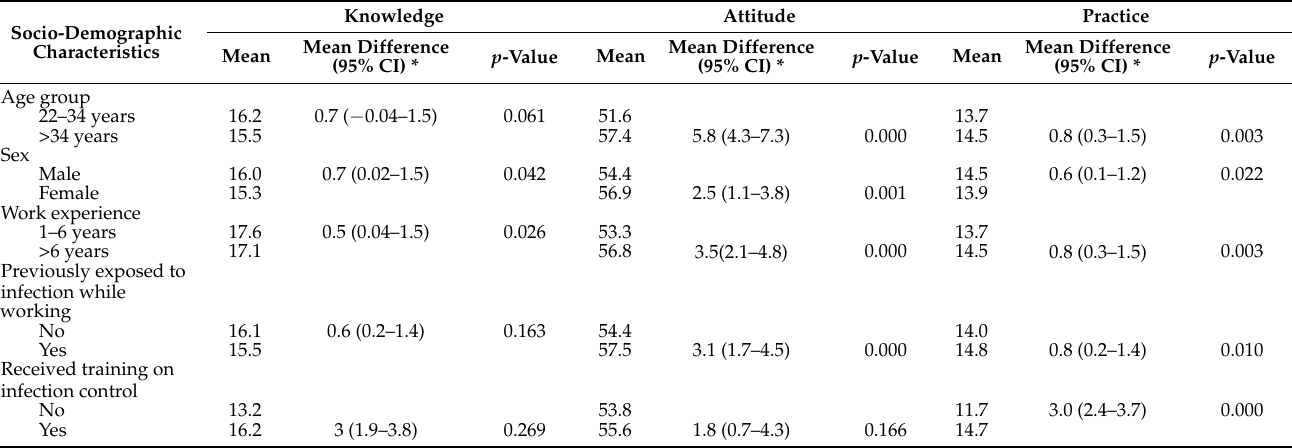
Table 6. Differences between mean standard infection control standard precautions knowledge, attitude, and practice scores between different HCWs, Qassim University Hospital,